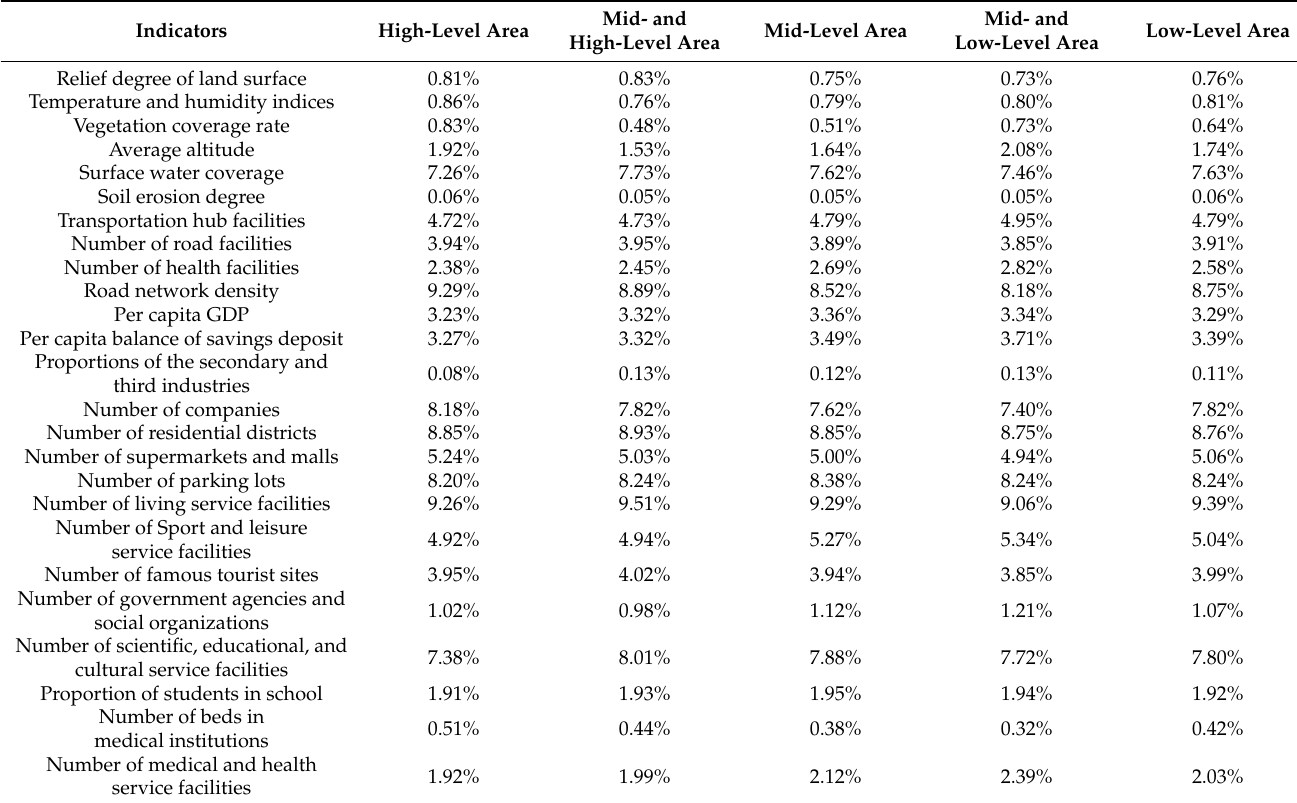
Table 3. Obstacle degree against human settlement quality across different regional levels in the Qinghai–Tibet Plateau.